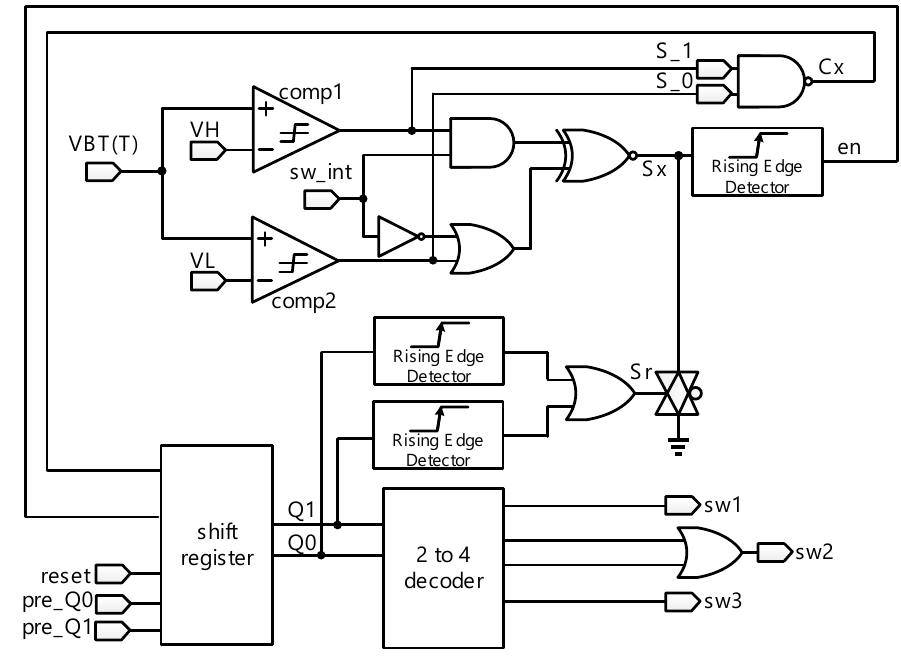
Figure 5. Schematic of temperature range auto-selecting circuit.